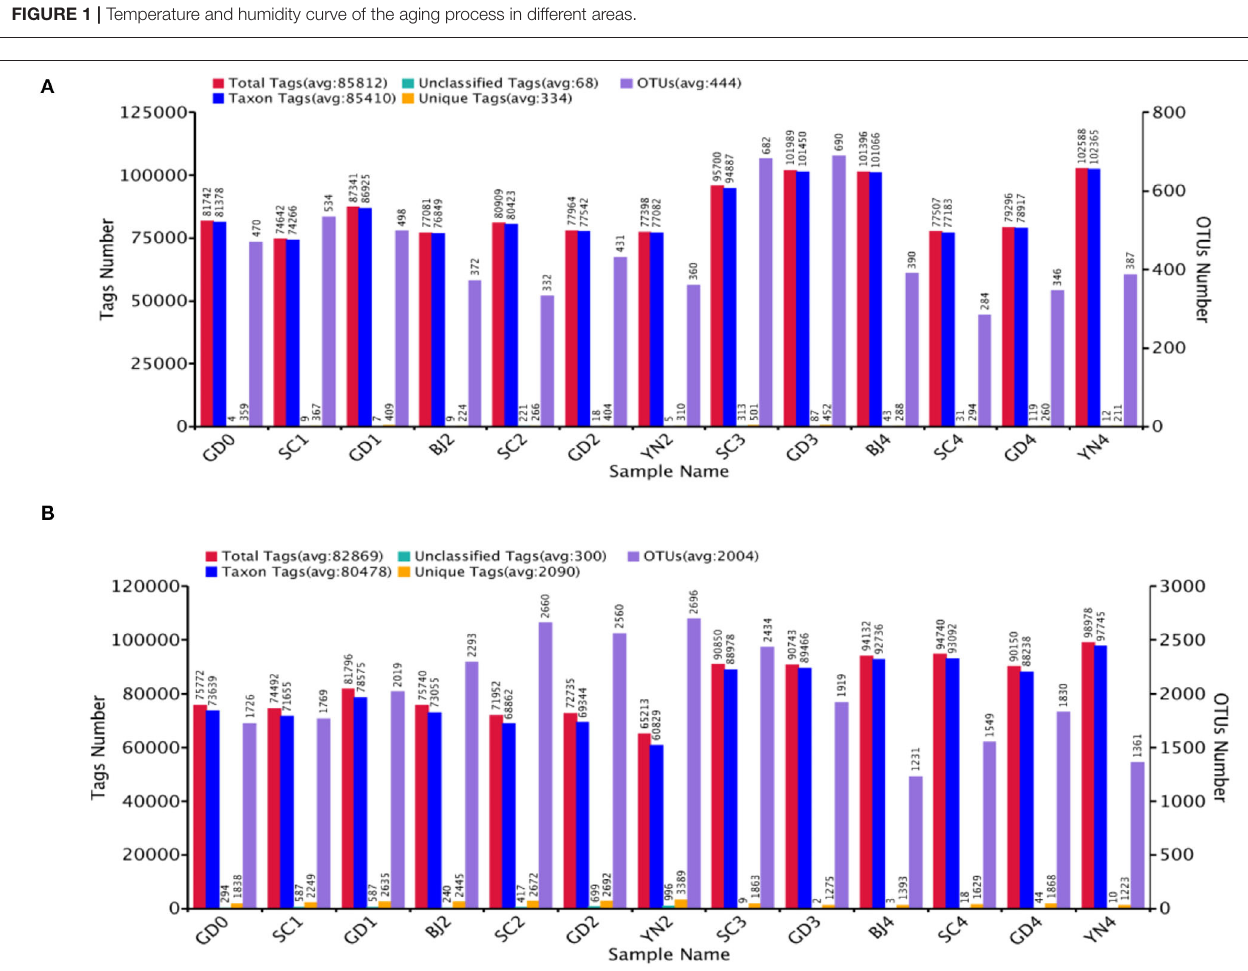
FIGURE 2 | (A) The number of tags and OTUs of fungi in Citrus reticulata “Chachi” samples. (B) The number of tags and OTUs of bacteria in Citrus reticulata “Chachi” samples. Total Tags: the total number of stitching sequences after filtering, Taxon Tags: the number of tags that build OTUs and provide information about classification, Unclassified Tags: the number of tags that build OTUs but do not provide any information about classification, Unique Tags: the number of tags with a frequency of 1 which cannot be clustered into OTUs, OTUs: the final number of OTUs.